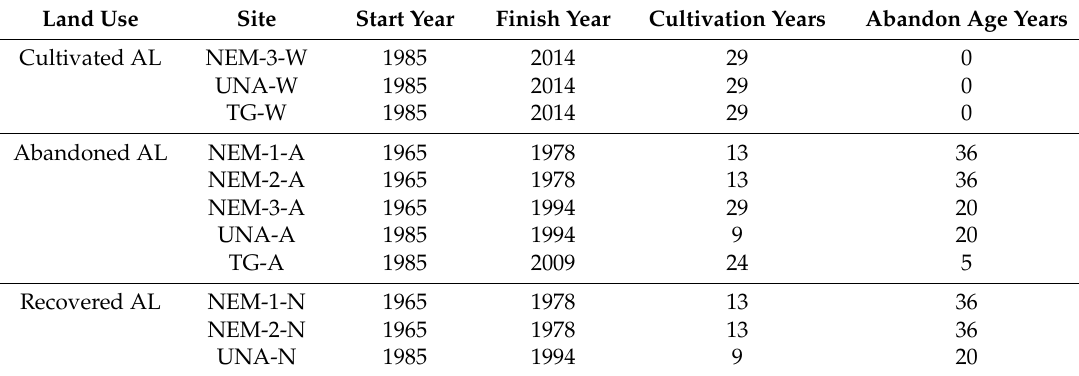
Table 1. Cultivation and abandonment age in the different type of arable